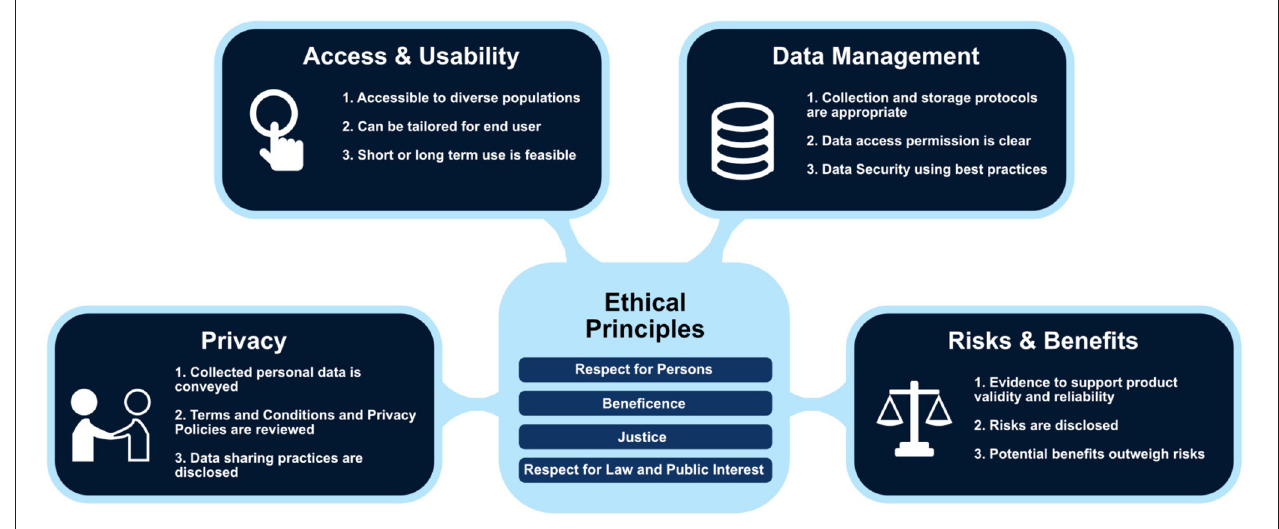
FIGURE 1 | Digital Health Framework with examples of checklist prompts embedded within each domain (Used with permission of C. Nebeker, ReCODE